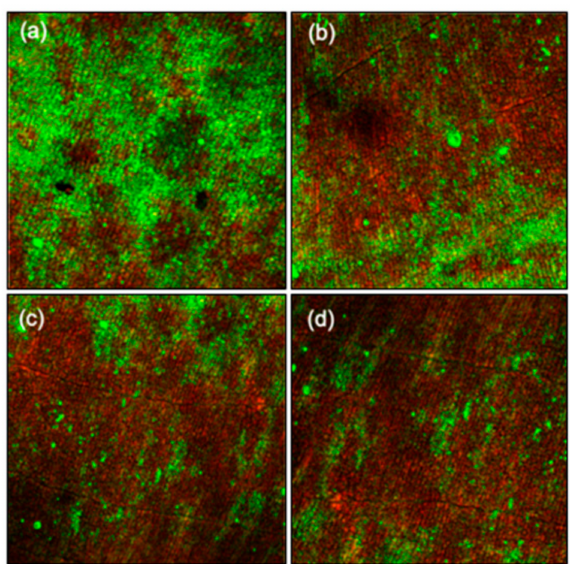
Figure 2. Representative confocal laser scanning microscopy images. ( a ) After exposure to saline (control); ( b ) after exposure to 4% NaOCl pH 12; ( c ) after exposure to acidified 4% NaOCl pH 6.5; and ( d ) after exposure to 4% NaOCl pH 12, followed by acidified 4% NaOCl at pH